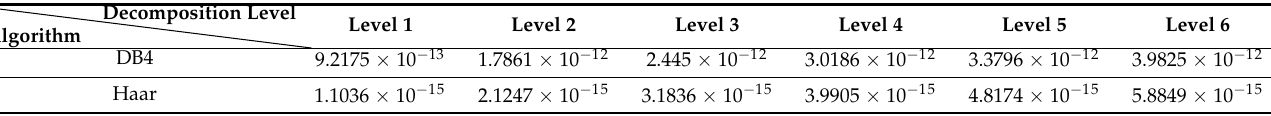
Table 3. The measured gas data reconstruction effect